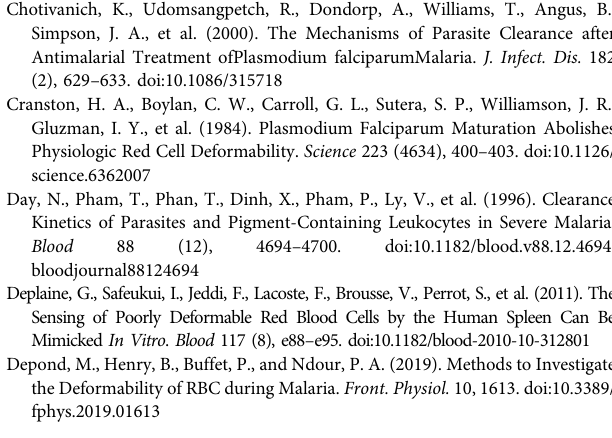
PE ratio ( Figure 2 ) associated with membrane destabilization (Chabanel et al., 1983; Janero 1990; Martinez-Vieyra et al., 2019). Taken together, these data showed that infection by